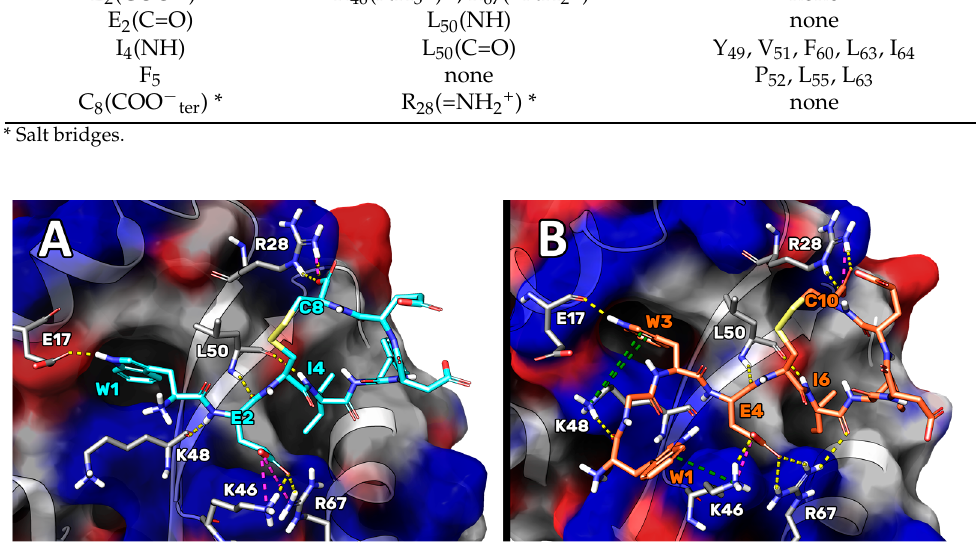
Figure 3. Depiction of the representative structure of the most populated cluster of conformations assumed by WC8 ( A ) and WC10 ( B ) in the complex with GABARAP. The GABARAP solvent- accessible surface is shown accordingly by residue charges: blue for positive and red for negative residues, respectively. The interactions between complexes are represented in colored dashes: yellow for H-bonds, purple for salt bridges, and green for cation- π . Table 3. List of the interactions established by the GABARAP/WC8 complex during MD simula- tions.